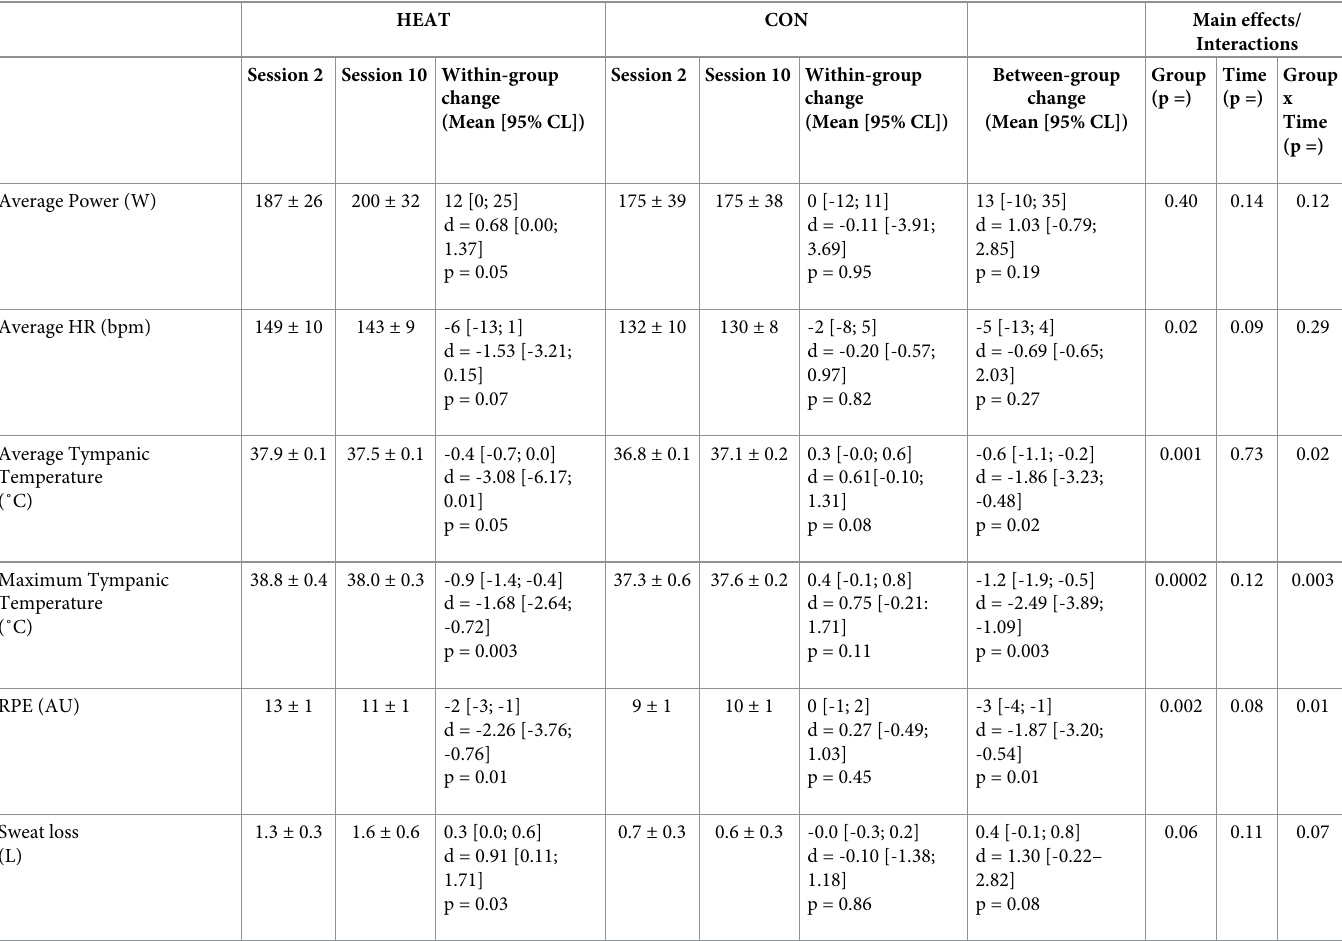
Table 1. Comparison of physiological and perceptual measures taken during Session 2 and Session 10 of a heat acclimation intervention in well-trained